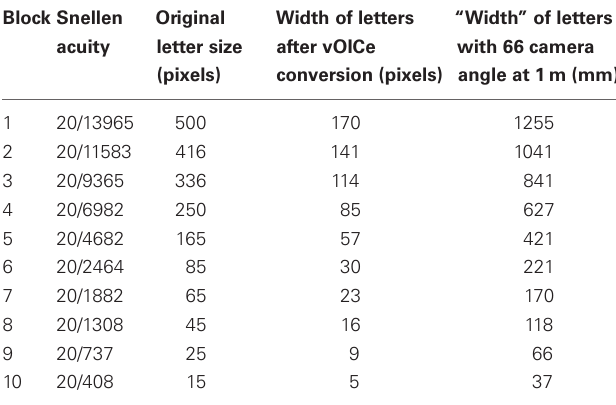
Table 1 | Size and acuity values of the optotypes used in each